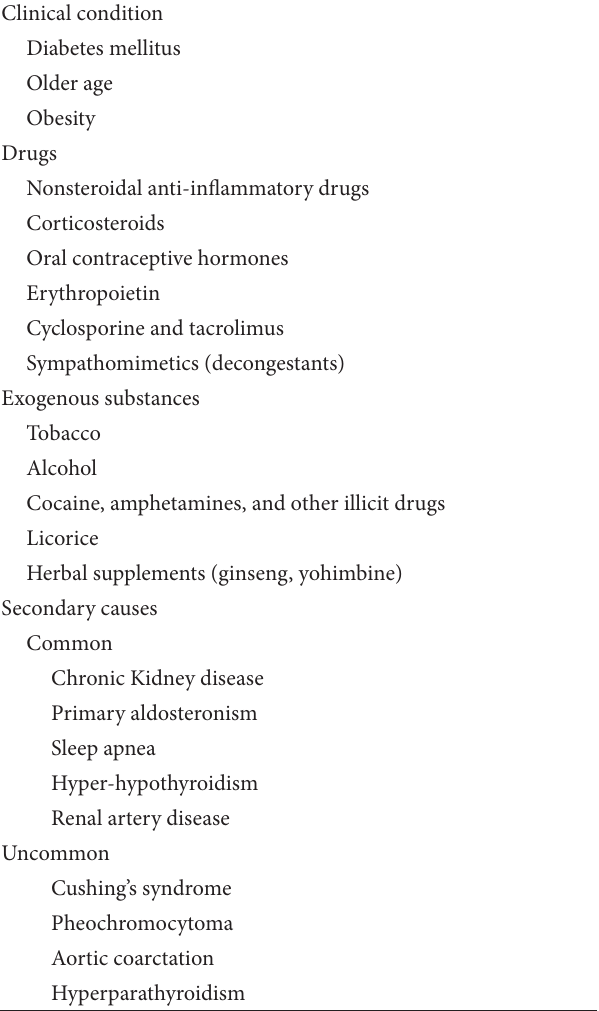
Table 1: Determinants of resistant hypertension in general popula-